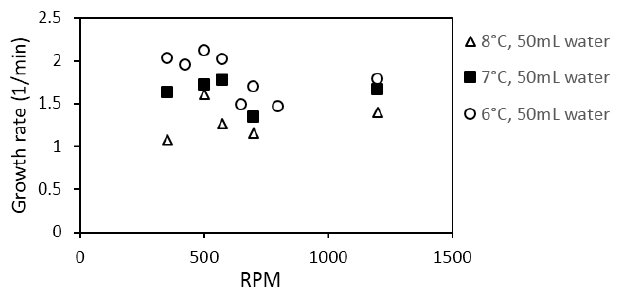
Figure 15. Effect of stirring rate on growth rate in a 141.4 mL cell (50 mL water content).